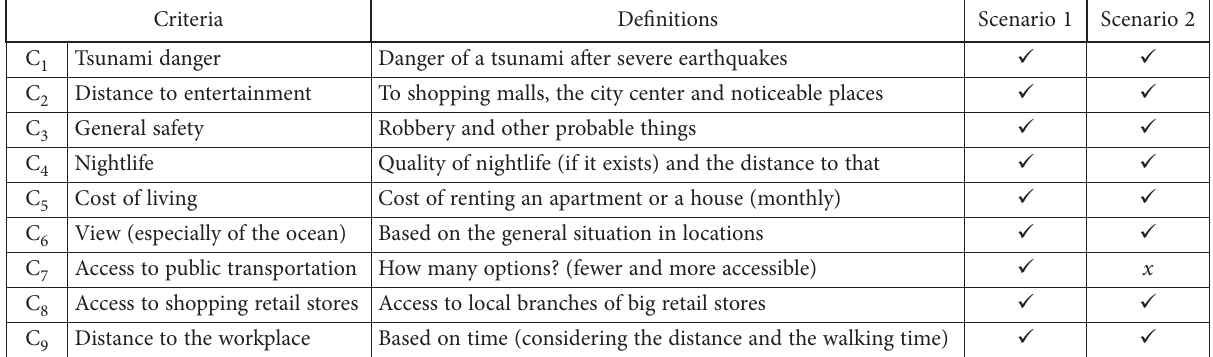
Table 3. The main criteria for evaluating different neighborhoods based on Scenarios 1 and 2 Criteria